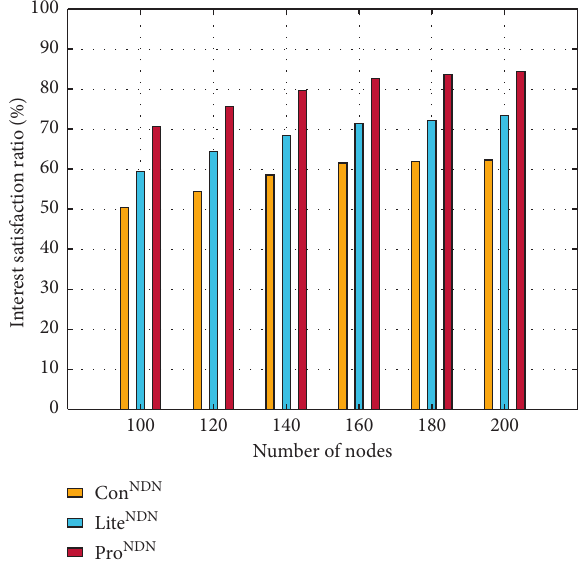
Figure 10: The performance of Interest satisfaction ratio against the number of